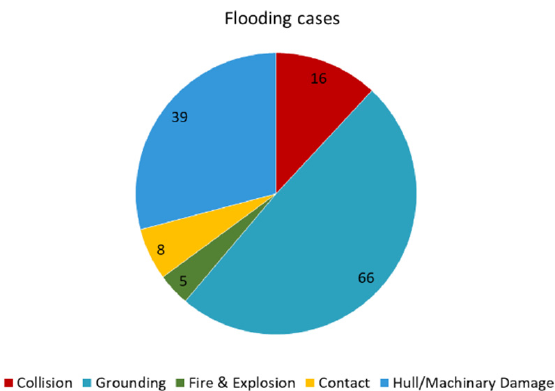
Figure 13. Number of flooding cases for different accidents registered over the last 20 years for Cruise and RoPax ships.